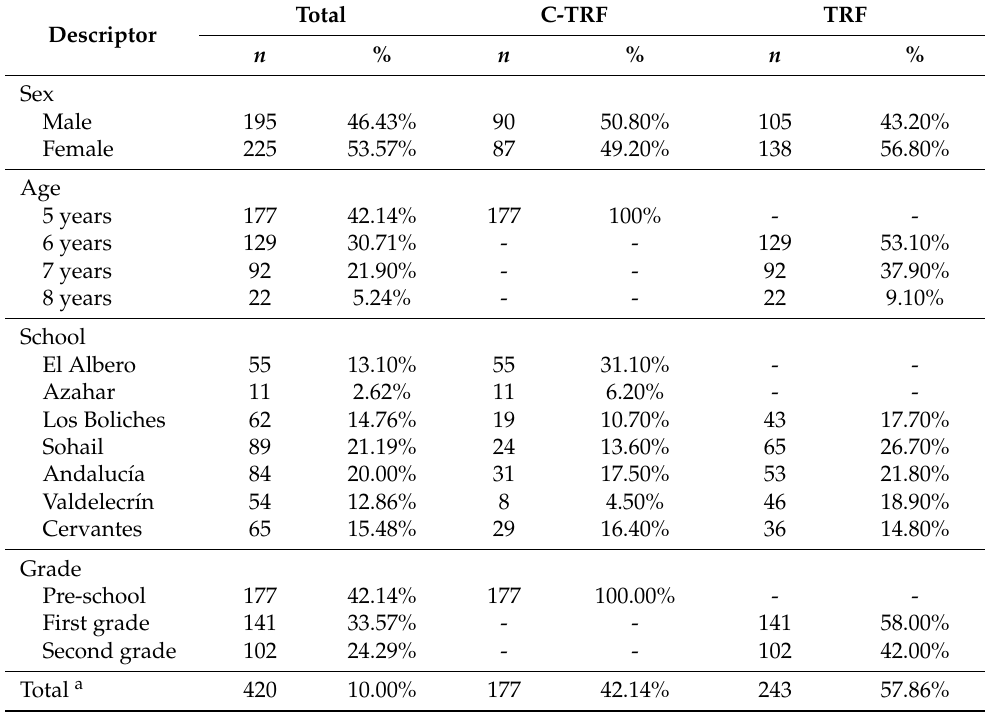
Table 1. Characteristics of the sample.